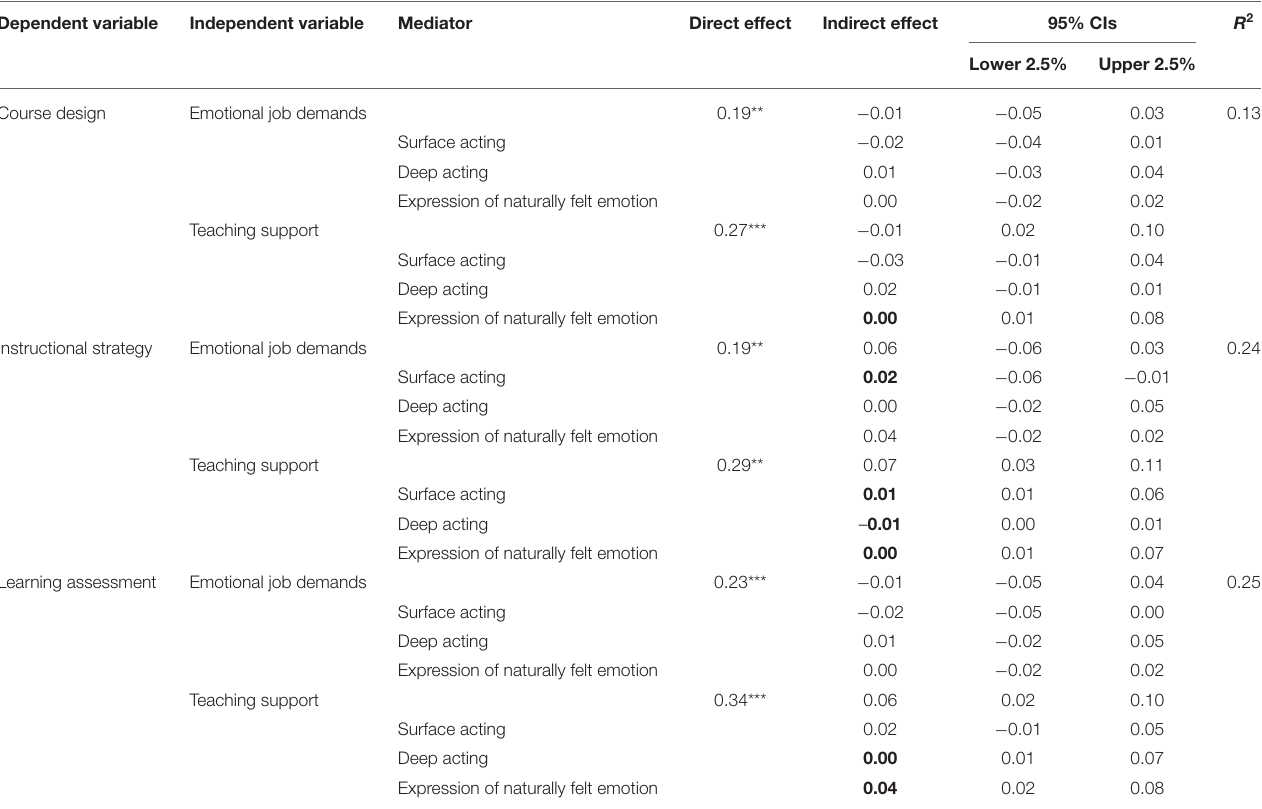
TABLE 2 | The estimates of direct effects and indirect effects of the 95% confidence